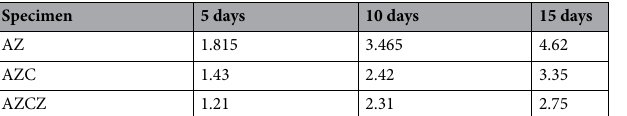
Table 4. The calculated corrosion rates (mm/year) at different time intervals based on the hydrogen evolution data.